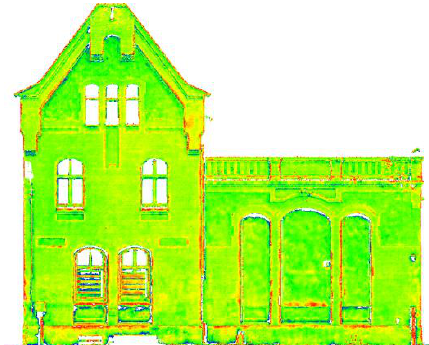
closest points algorithm) of the software CloudCompare. The resulting cloud-to-mesh distances for a facade are shown in Figure 16. The standard deviation of roughly 6mm successfully fulfils the demands of the project.